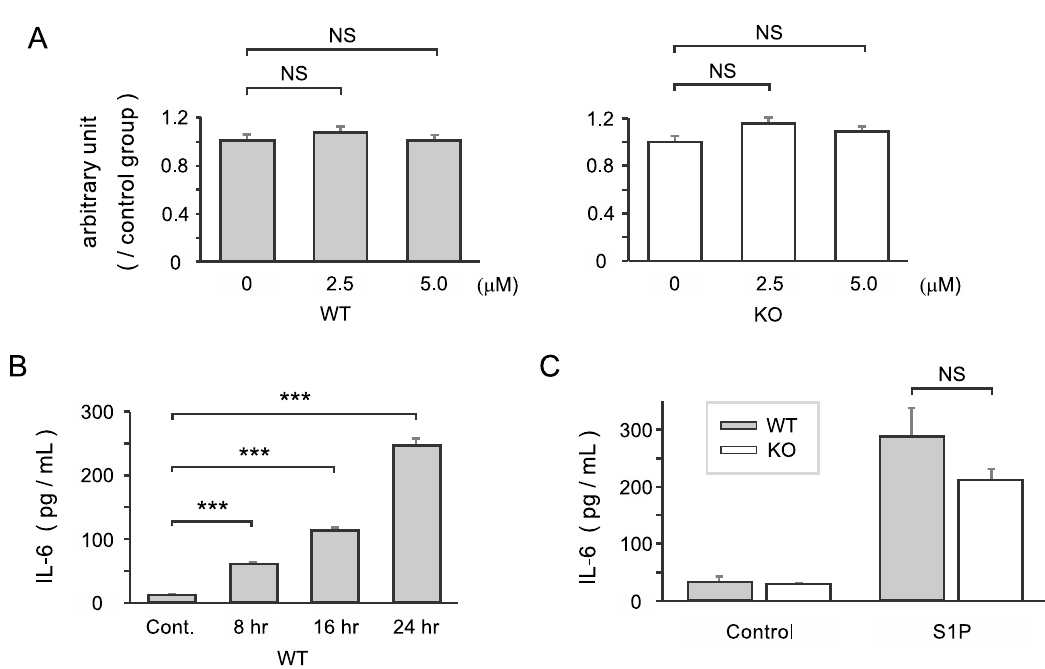
Fig 3. Effect of sphingosine-1-phosphate on cell proliferation and IL-6 production by cultured fibroblast-like synoviocytes. (A) FLSs were cultured for 48 hours with S1P (0, 2.5, and 5.0 μ M) and proliferation assays were performed. The results are presented as a ratio with respect to the control group. (B) IL-6 levels in supernatants from WT FLSs cultured with 5 μ M S1P for the indicated periods of time were measured in an ELISA. (C) WT and S1P 3 -KO FLSs were incubated with 5 μ M S1P for 24 hours, and IL-6 production was compared. Results are presented as the mean ± SEM (n = 4 samples per group) and were analyzed by one-way ANOVA followed by Dunnett’s test (A, B) or a t -test (C). � P < 0.05, �� P < 0.01, ��� P < 0.001, NS = not significant.